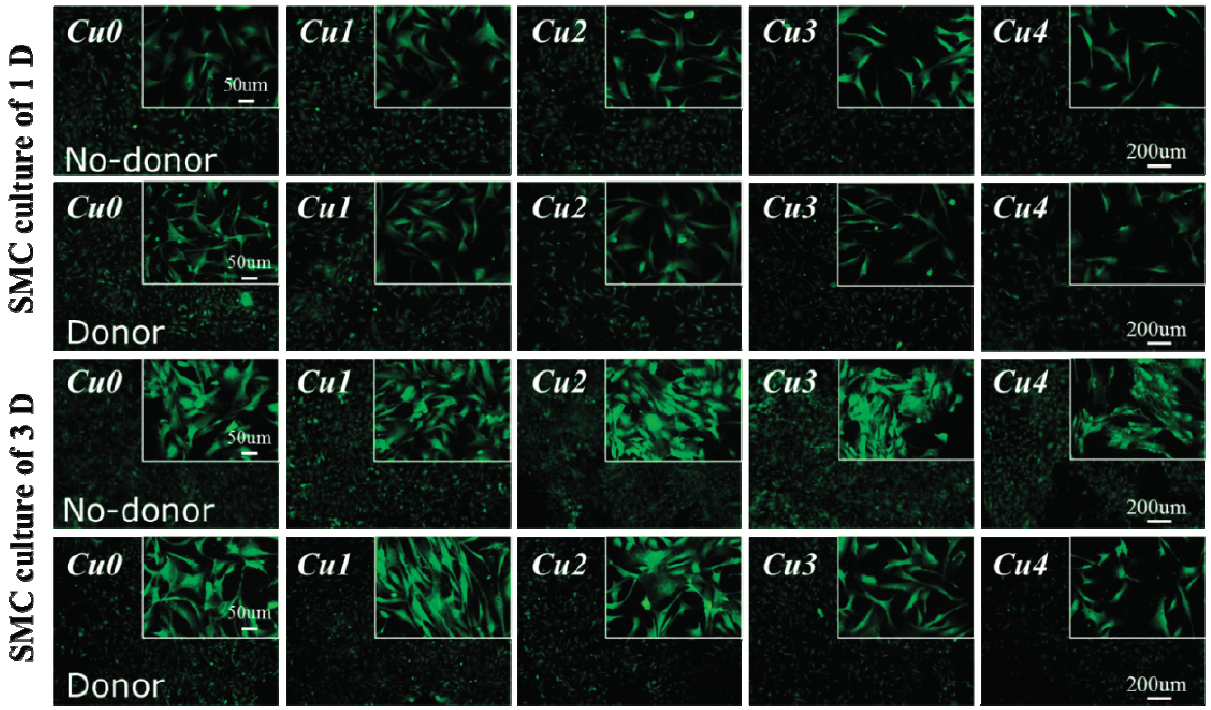
Figure 6. The fluorescence staining of SMC on the Cu0, Cu1, Cu2, Cu3 and Cu4 surfaces after one day and three days of culturing,